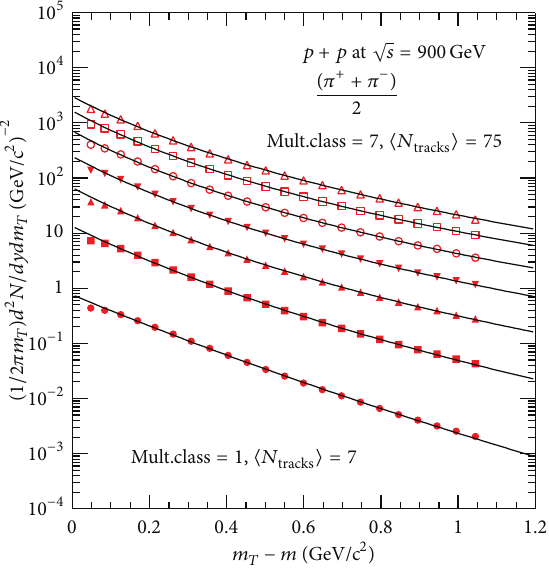
Figure 3: The variation of the Tsallis parameter 𝑇 for charged pions as a function of √𝑠 . The solid curve represents the parameterization (𝑎 + (√𝑠) −𝛼 ) 𝑏 . extrapolated values for 𝑛 , 𝑇 and 𝑑𝑁/𝑑𝑦 for √𝑠 = 14 TeV are 𝑛 ∼ 5.09 , 𝑇 ∼ 90.33 MeV, and 𝑑𝑁/𝑑𝑦 ∼ 3.44 .